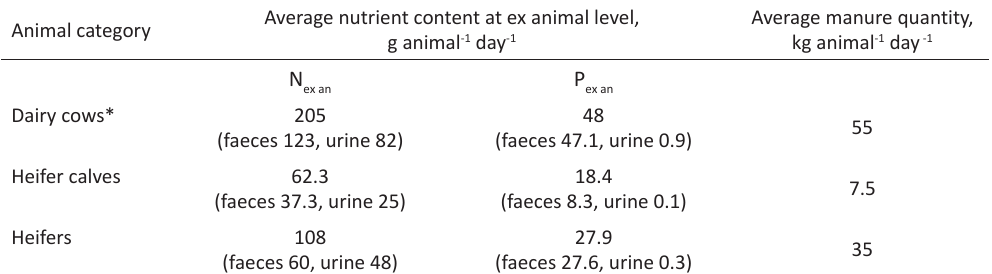
Table 1. Russian regulatory data on total nitrogen and phosphorus content in dairy cattle manure at ex animal level (faeces +